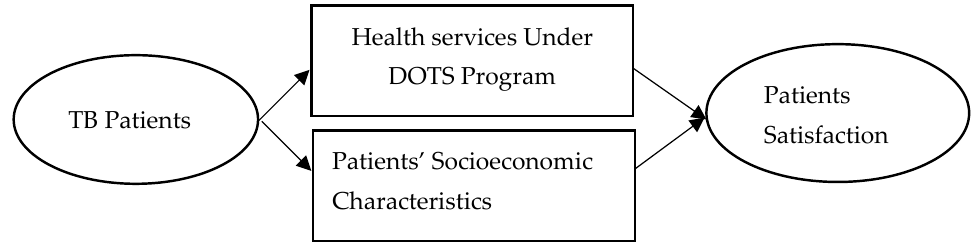
Figure 1. Conceptual framework.